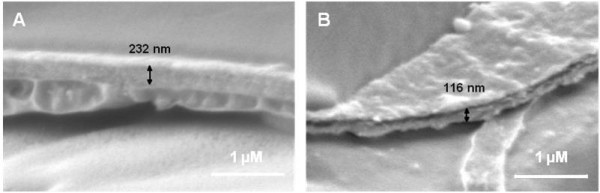
Scanning electron micrographs of typical cell walls in fractured grapevine callus cells. A) Untreated; B) incubated with H2O2. Scale bars equivalent to 1 μm are indicated in the bottom, right hand corners of the panels. Both samples were equilibrated in 15 mM KCl prior to freeze-fracture.